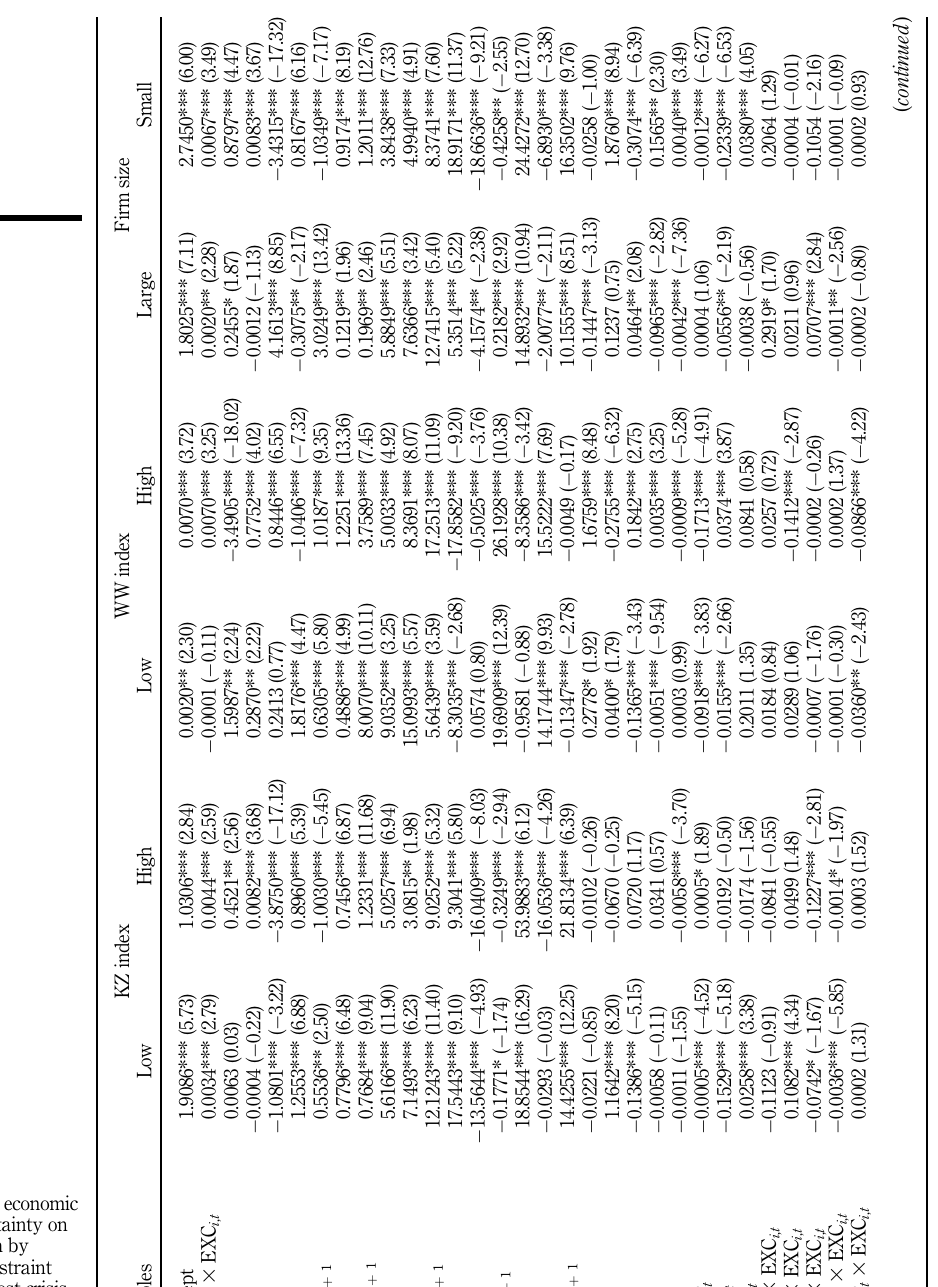
Table 7. The effect of economic policy uncertainty on value of cash by financial constraint during the post-crisis